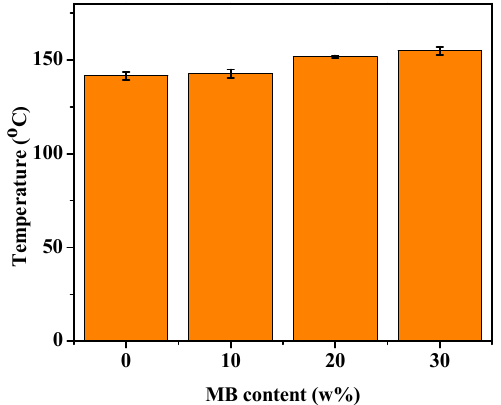
Figure 7. HDT of the PHBV and PHBV/MB composites.